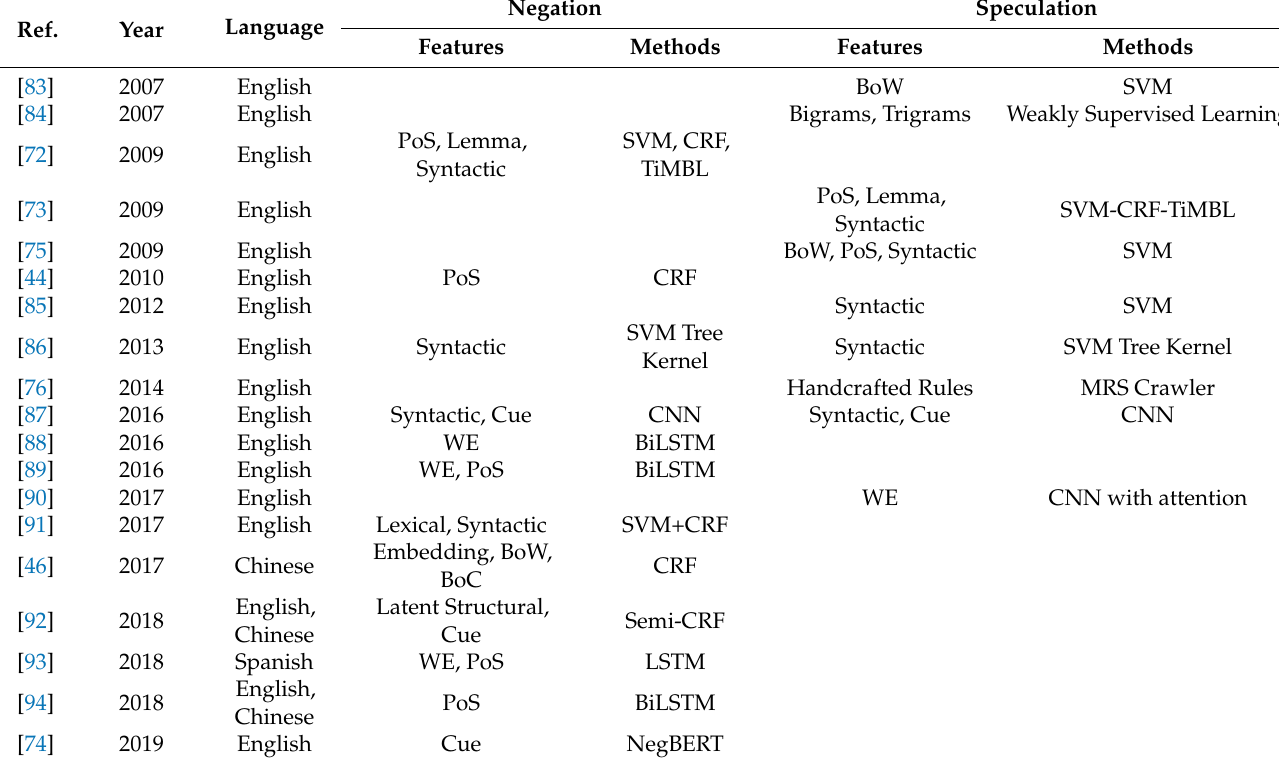
Table 3. Supervised techniques for negation and speculation detection.